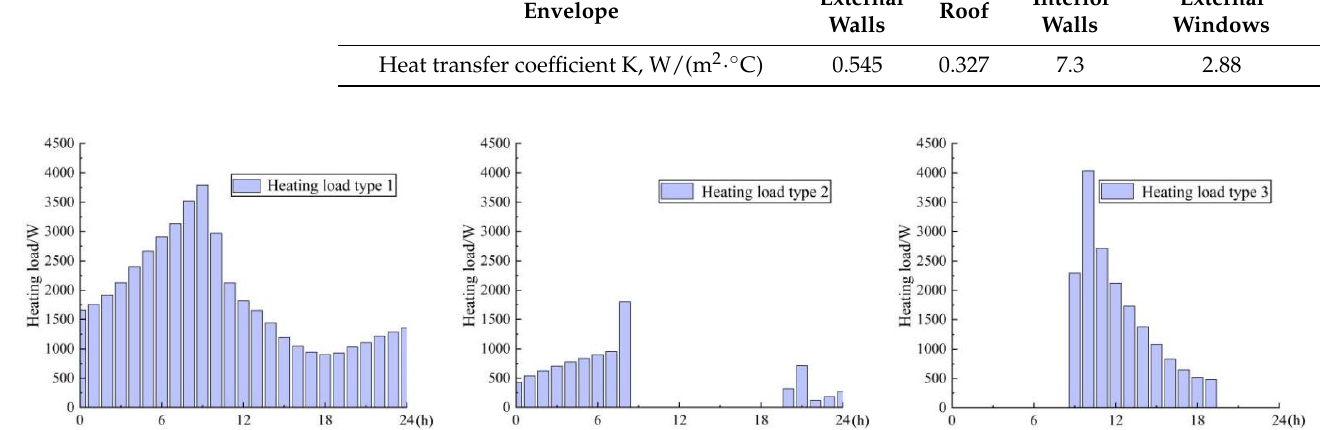
Figure 4. Three typical daily heating loads on 17